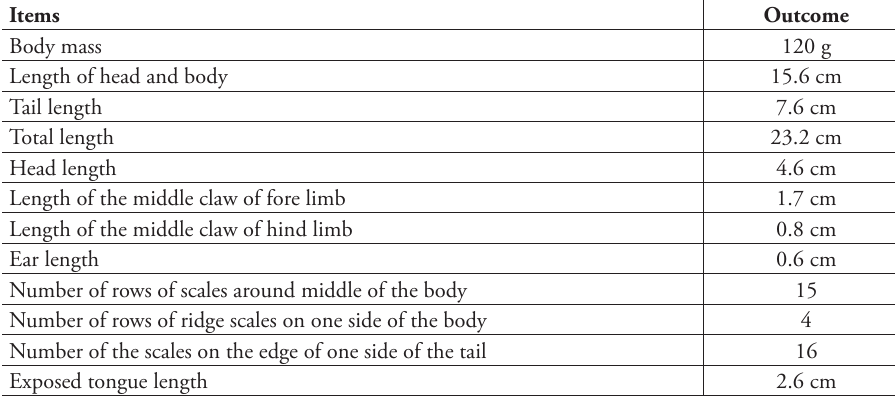
Figure 3. The newborn Chinese pangolin baby MP86 (by Fuhua Zhang, 19 Oct 2011). Table 1. Measurements of the morphological indexes for the baby